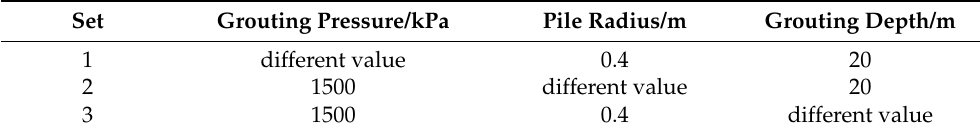
Table 1. Grouting pressure, pile radius, and grouting depth of 15 samples for calculation. Set Grouting Pressure/kPa Pile